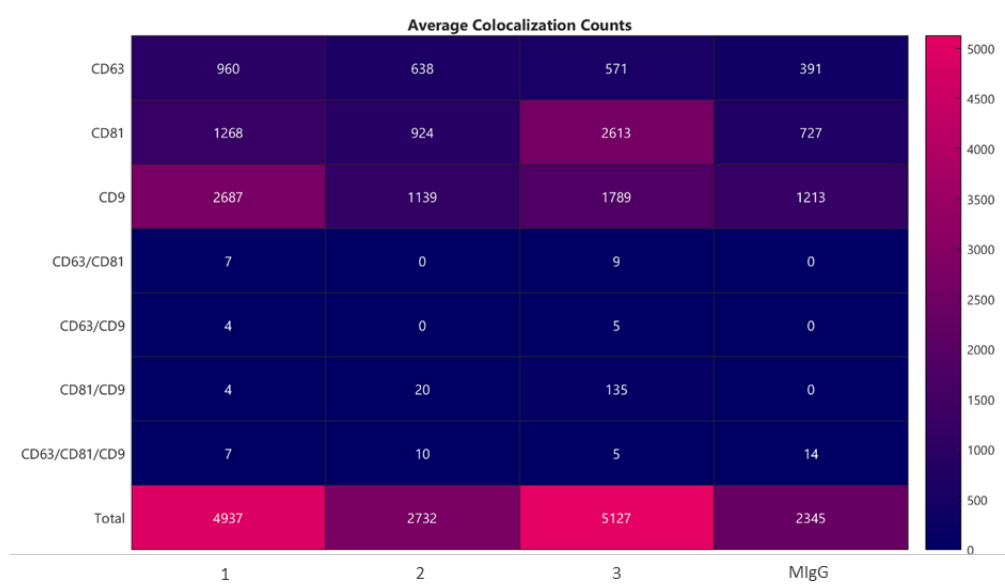
Figure 5. Average colocalization counts evaluating the correlations between proteins expressed on exosome’s surfaces and fluorescent antibodies markers CD63, CD81, and CD9. According to the average results of the three determinations (without considering the negative control murine IgG), it is possible to underline that there were 723 exosomes positive only for the anti-CD-63 human antibody, approximately 1601 exosomes positive only for the anti-CD-81 human antibody, 1871 exosomes positive only for the anti-CD-9 human antibody, 5 exosomes have a double positive match for anti-CD-81 and anti-CD-63 human antibodies, approximately 5 exosomes have a double positive match for anti-CD-63 and anti-CD-9 human antibodies, 53 exosomes are simultaneously positive for anti-CD-9 and anti-CD-81 human antibodies, and 7 exosomes present a triple positive match for human antibodies.